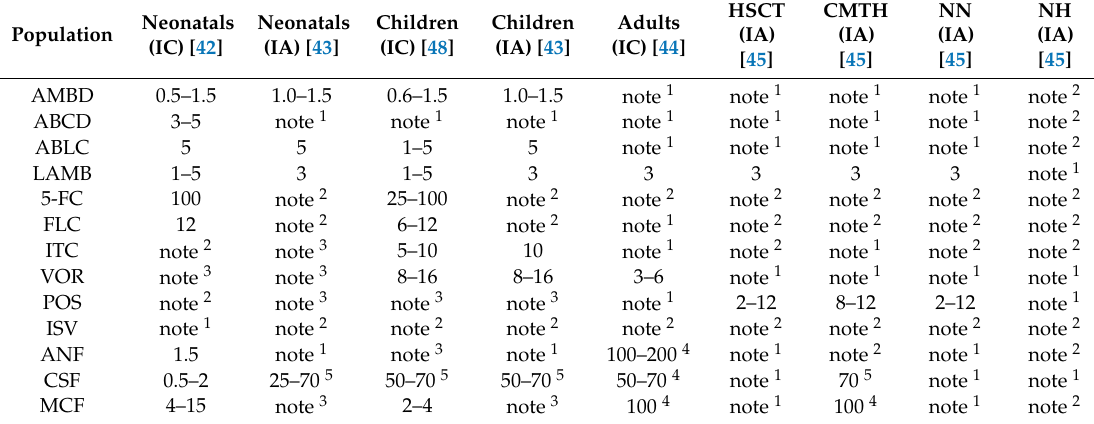
Table 3. Antifungal drug dosages [mg/kg/day] for intravenous administration only during the initial therapy of invasive fungal infections in selected patient populations. IC = invasive candidiasis, IA = invasive aspergillosis, HSCT = patients under hematopoietic stem cell transplantation, CMTH = patients under chemotherapy, NN = non-neutropenic patients, NH = non-hematological patients.